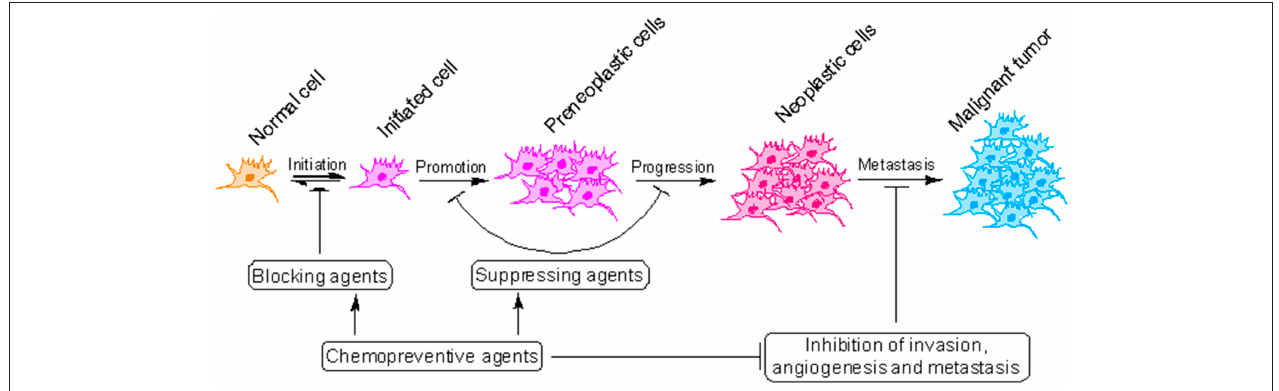
FIGURE 2 | Critical steps in the process of cancer development. Cancer initiates with the transformation of a normal cell into an initiated cell, which undergoes tumor promotion to form preneoplastic cells and finally progress to neoplastic cells. Cancer chemopreventive agents can interfere with initiation (blocking agents) or later steps of this multi-stage process (suppressing